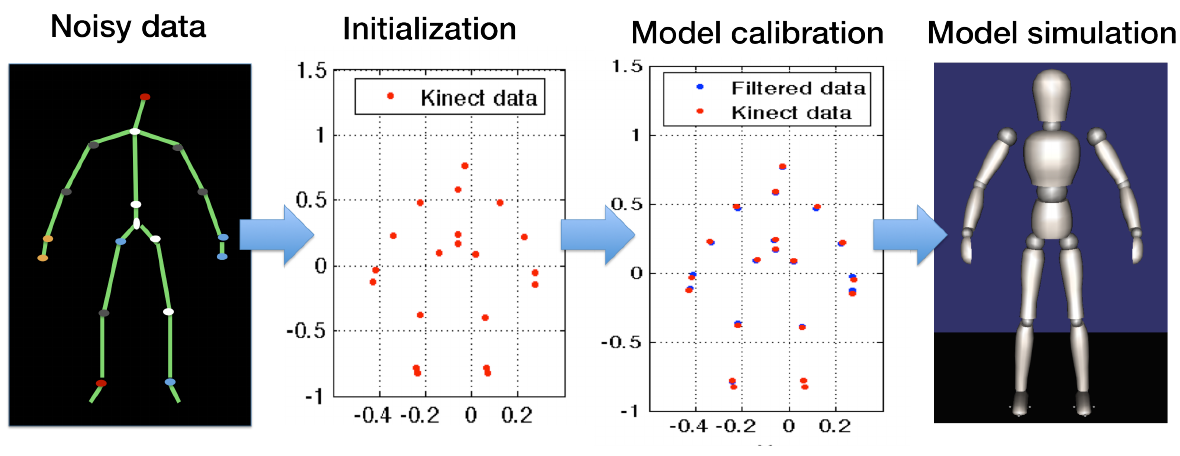
Figure 16. Example of pose correction for a person in standing position. From the noisy data collected by the Kinect to the animation of the dynamic mannequin.